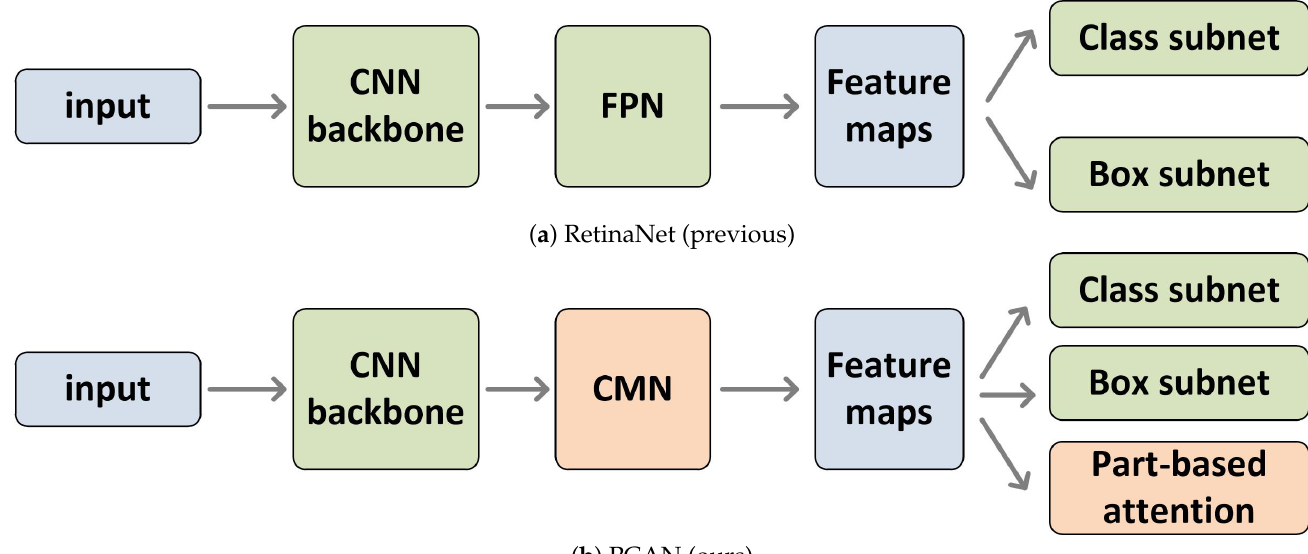
Figure 3. The illustration of the detection pipeline. ( a ) RetinaNet [12], a one-stage detection network, extracts deep features by ResNet [13] and Feature Pyramid Networks (FPN) [14], and then obtains locations and class labels of the anchors by box subnet and class subnet using focal loss. ( b ) part-based context attention networks (PCAN) uses a Context attention Multi-scale feature extraction Network (CMN) to generate multi-scale feature maps containing contextual information for irregular objects and a part-based attention module for the adaption of facility objects composed of distinctive